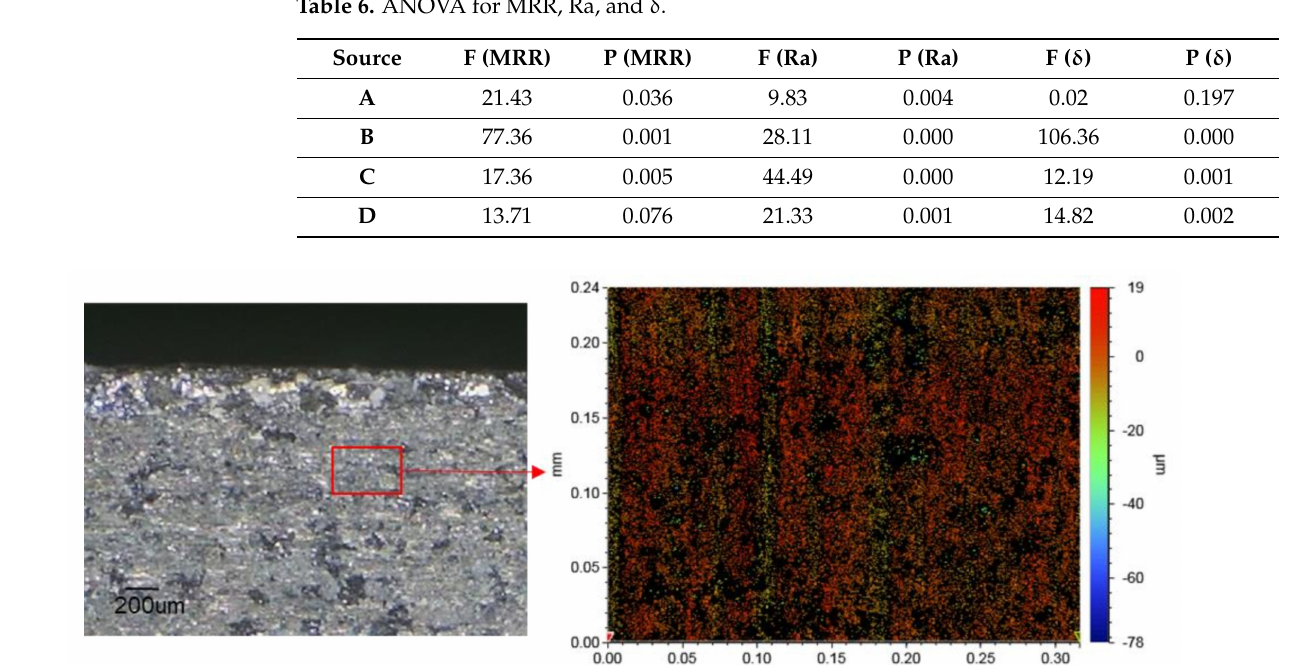
Figure 14. The machined surface and topography in optimized